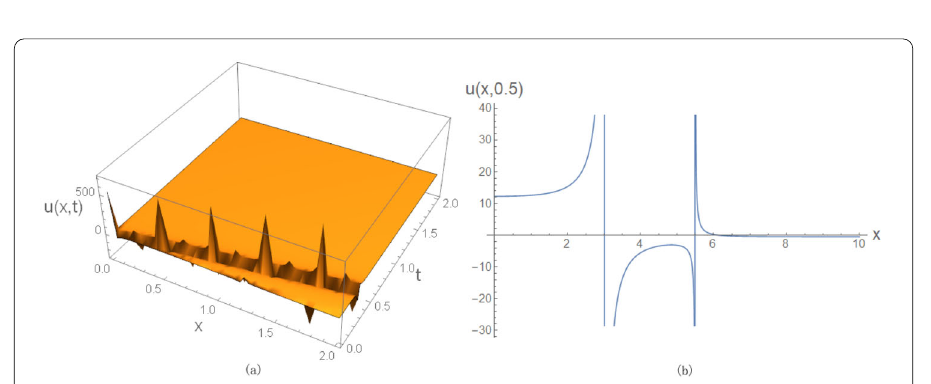
Figure 6 ( a ) Three-dimensional figure of (53), when κ = 1, c = 7 two-dimensional figure when t = 0.5